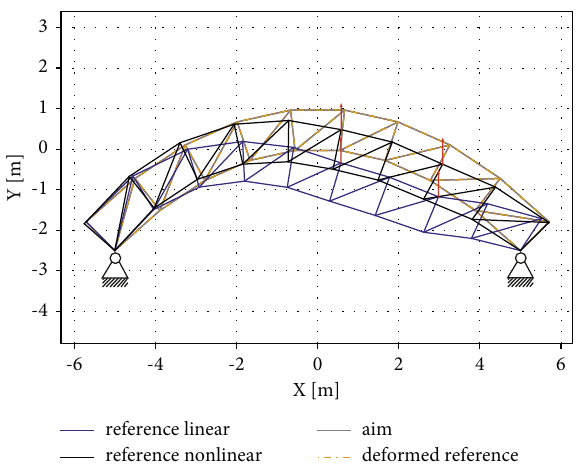
Figure 7: Unknown and known confguration of a two-dimen- sional bridge structure. Te red arrows demonstrate the force vector.